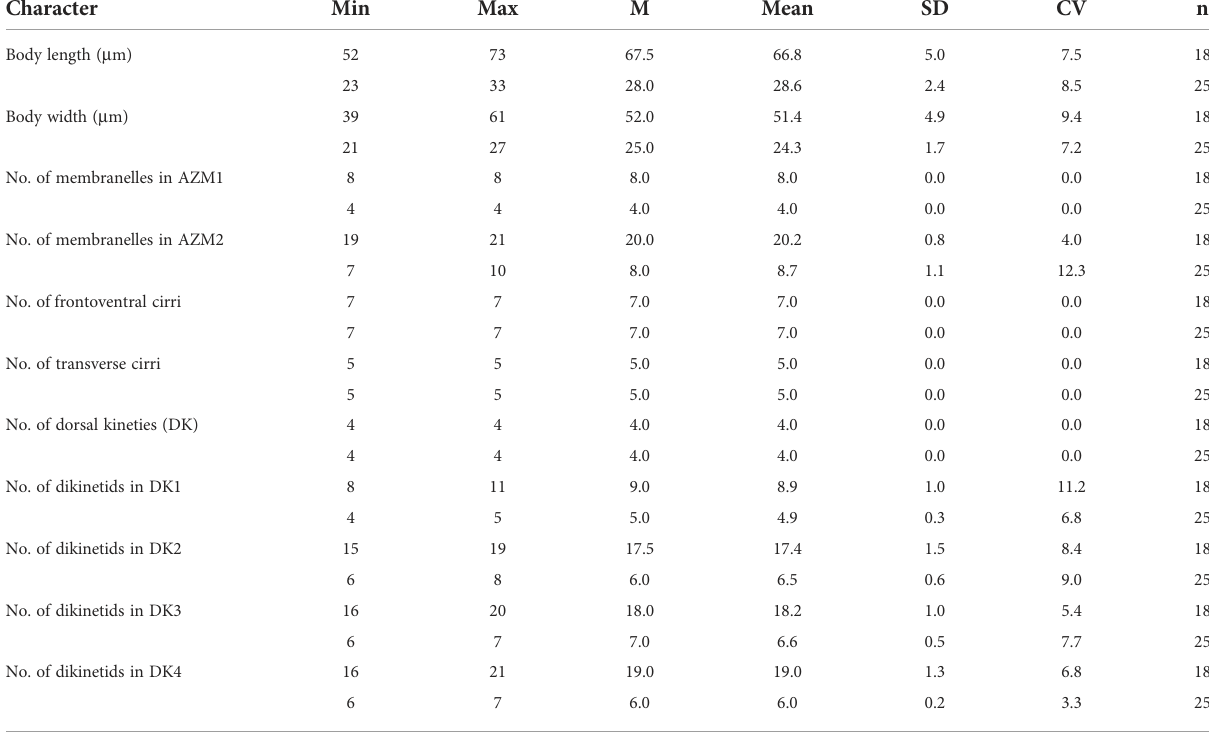
TABLE 1 Morphometric data of Aspidisca spina sp. n. (upper line) and A. shini sp. n. (lower line) based on protargol-stained